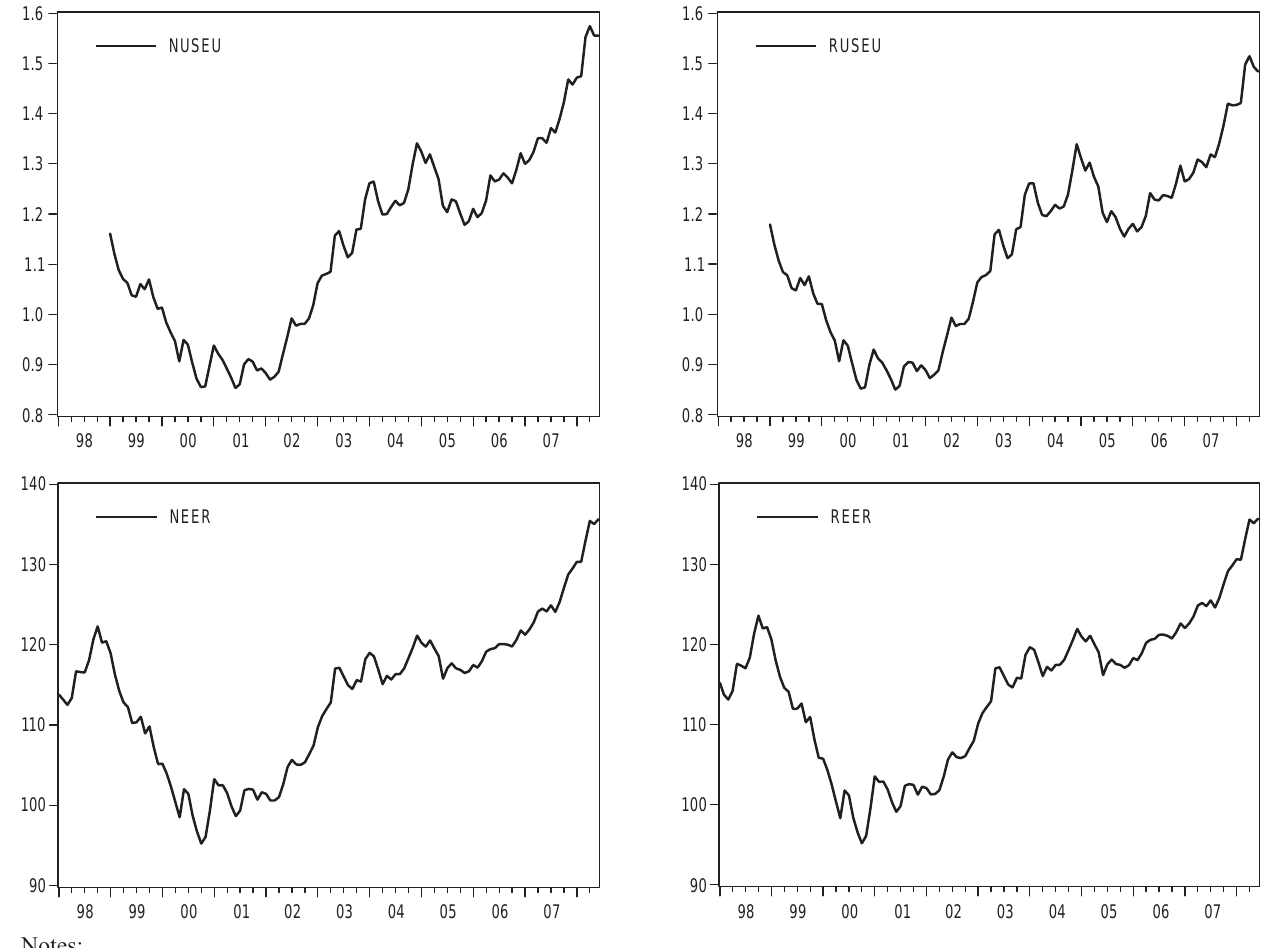
Fig. 1. The nominal and real exchange